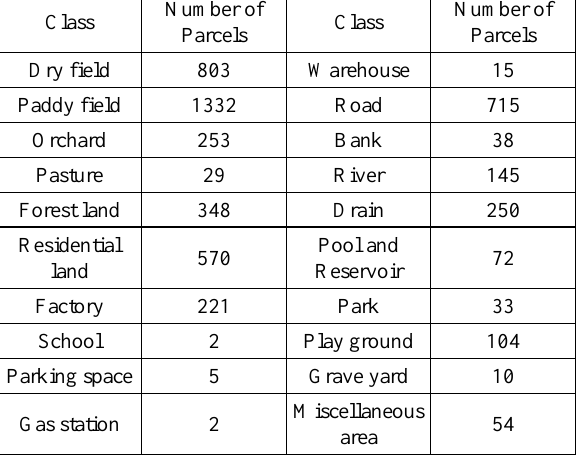
Table 2. Cadastral land classes within the study area